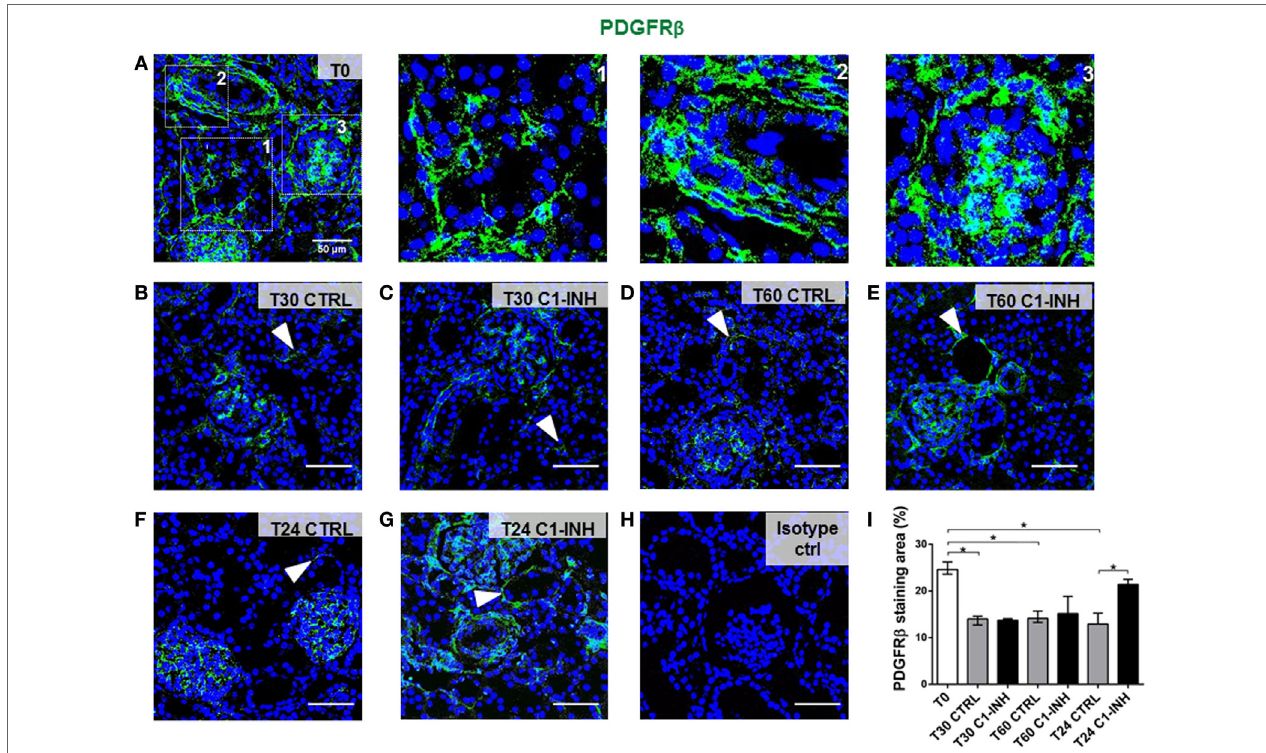
FigUre 1 | C1-INH treatment prevented PDGFR β downregulation after I/R injury. PDGFR β expression on paraffin sections at T0 (before ischemia) [ (a) , zoomed in 1, 2, 3 at right ], at 30 min (b,c) , 60 min (D,e) , and 24 h (F,g) after reperfusion. The groups analyzed were the CTRL (b,D,F) and C1-INH-treated pigs (c,e,g) . In the normal kidney (a) , PDGFR β + cells were localized in peritubular capillaries (1), in arterioles (2), in mesangial cells, and Bowman capsule (3). (b–F) Stainings showing that I/R injury induced the PDGFR β downregulation in the peritubular areas, whereas 24 h of C1-INH treatment protected from pericytes loss. Arrowheads point to representative peritubular capillaries PDGFR β + cells. (h) Isotype control for PDGFR β staining. Magnification 630 × , scale bar = 50 μ m. (i) PDGFR β + staining area was expressed as the median ± interquartile range of five independent pigs for each group. (F) * p <